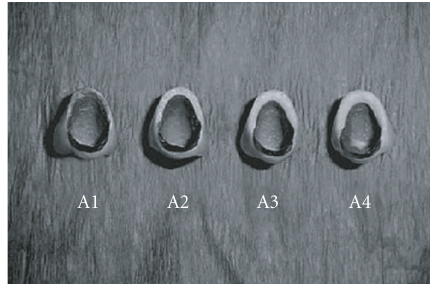
Figure 5: Model on Instron testing machine.